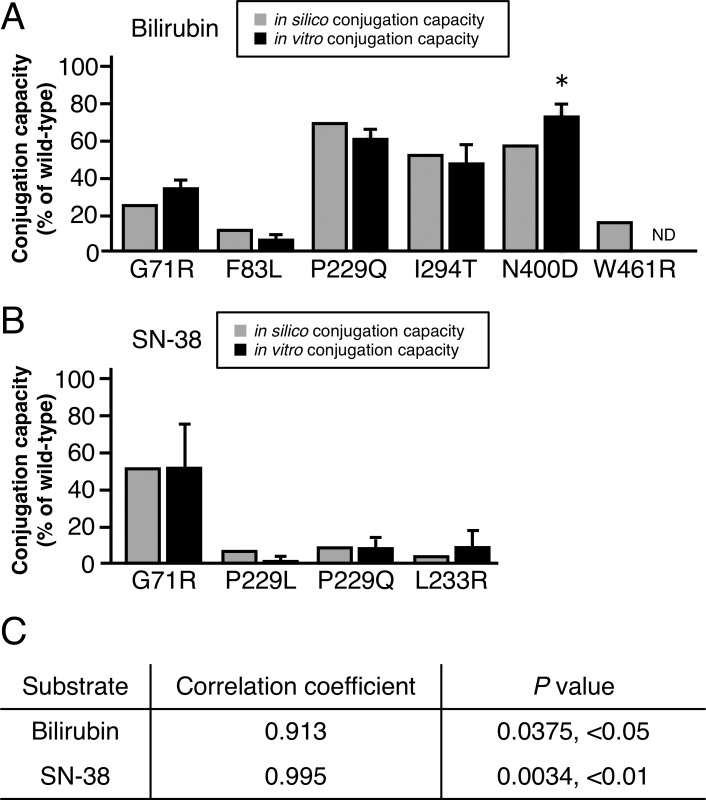
Verification of the prediction of in silico conjugation capacities of UGT1A1 mutants.(A) In silico conjugation capacities (gray bars) for bilirubin were calculated by using molecular docking results and our mathematical model and were compared with reported in vitro conjugation capacities (black bars). (B) In silico and in vitro conjugation capacities of SN-38 were compared similarly, as done for bilirubin. (C) Pearson's correlation coefficient was used to analyze the correlation between in silico and in vitro conjugation capacities. *, Calculated from in vivo conjugation capacity [5]. ND, not detected.